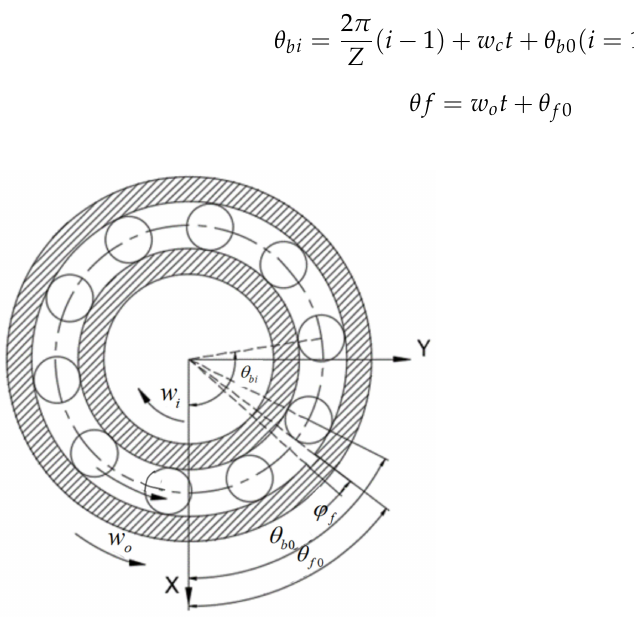
Figure 5. Roller and defect angular position of OR fault.